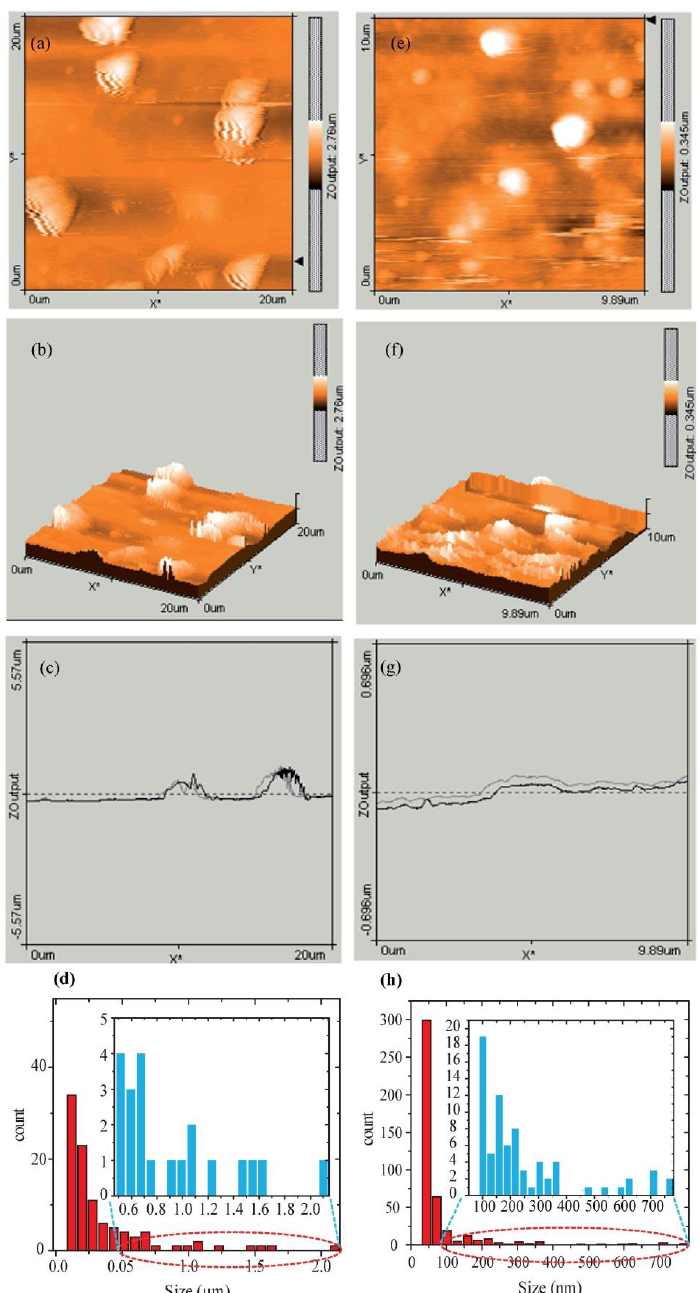
Figure 3. Atomic force microscope (AFM) images of the nanocluster deposited at pressure, voltage, and current of 25 mbar, 0.43 kV, and 240 mA, respectively. ( a , b ) Two-dimensional and 3-dimensional views of the low-resolution AFM scan of 63.7 µ m × 64.3 µ m. ( c , g ) AFM scan profile for low-resolution and high resolution captured during scanning. ( d ) Histogram of nanocluster size shown in ( a , b ). ( e , f ) Two-dimensional and 3-dimensional views of the high-resolution AFM scan of 32.6 µ m × 32.8 µ m. ( h ) Histogram of nanoclusters of a high-resolution AFM scan.